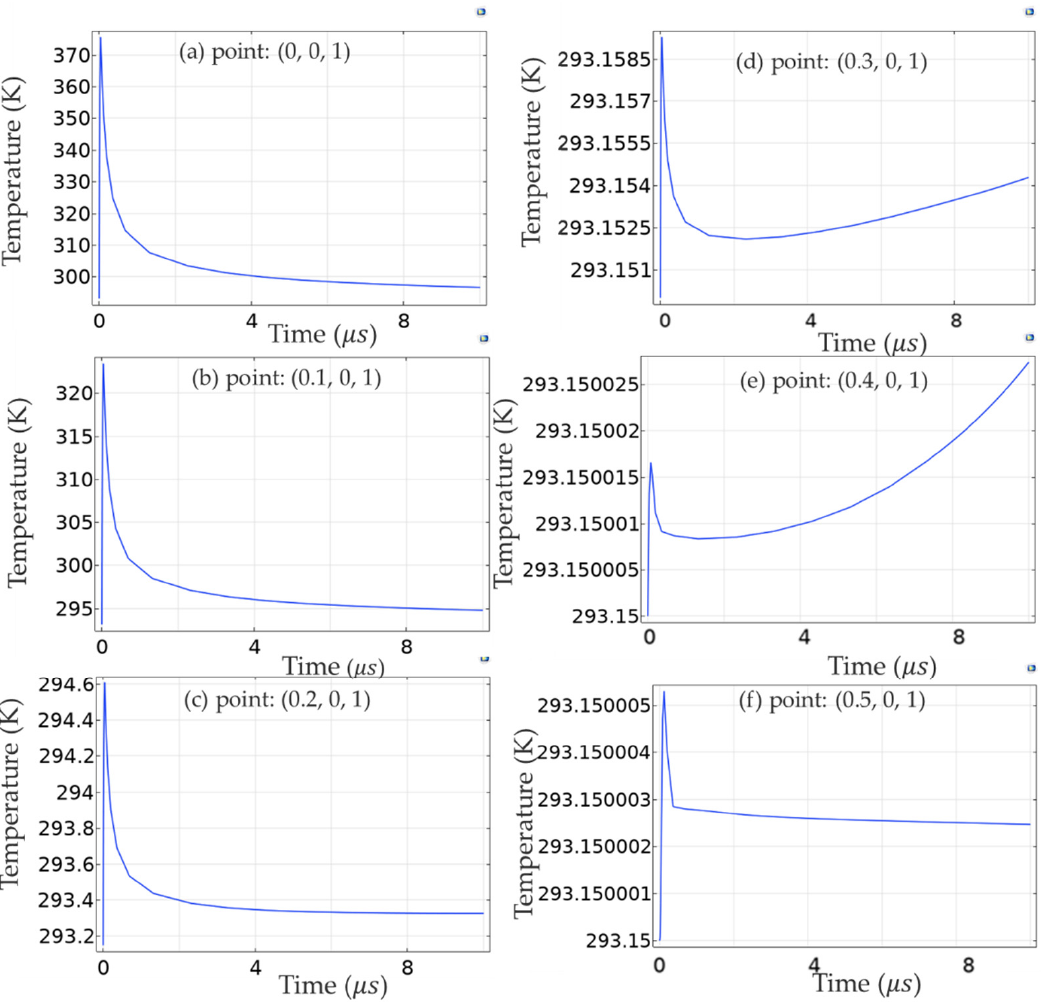
Figure 6. The temperature changes vs. time in different points on the silicon surface in model 2. By comparing Figures 4 and 6, and Figures 5 and 7, it can be found that the overall changing trend of temperature or displacement at each point is similar. As shown in Figure 6a, the maximum temperature at the center point was 375 K, which is much lower than the melting point of silicon and, therefore, suitable for real-life